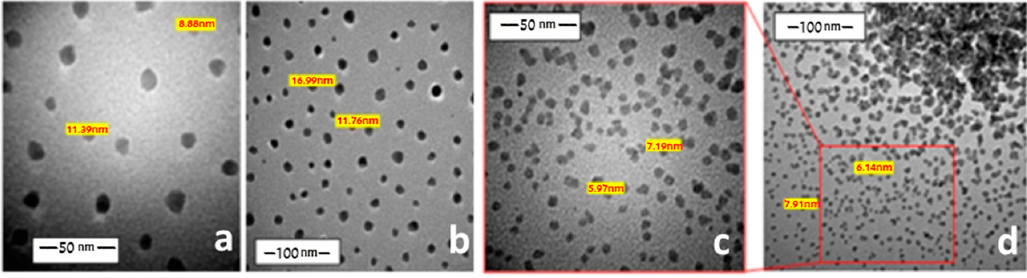
Figure 7. TEM images of some nano copper complex ( a , b ) and nano zinc ( c , d ) in the presence of PVA (10 − 6 M).